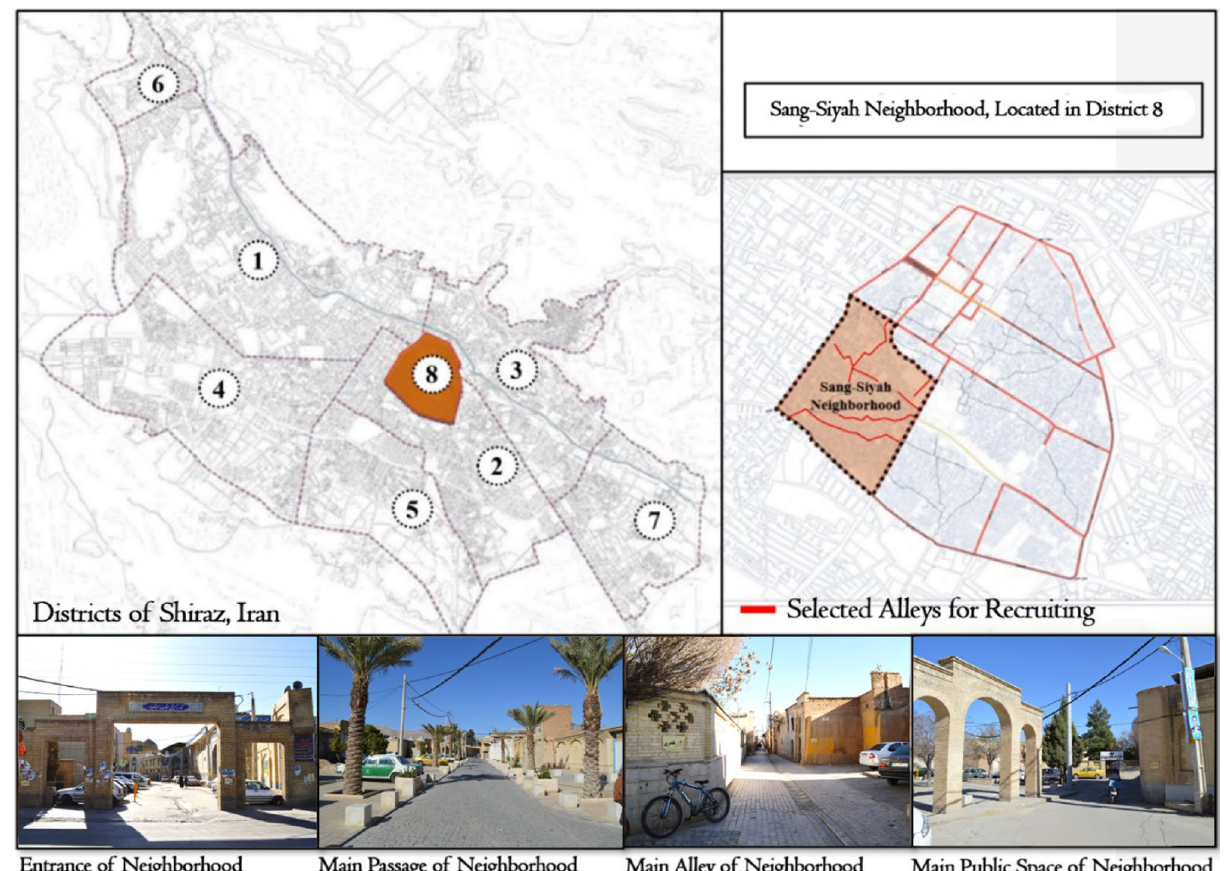
Figure 2. Location of the historical neighborhood of Sange Siah in historical fabric of Shiraz, Fars, Iran (Photos by: Sina